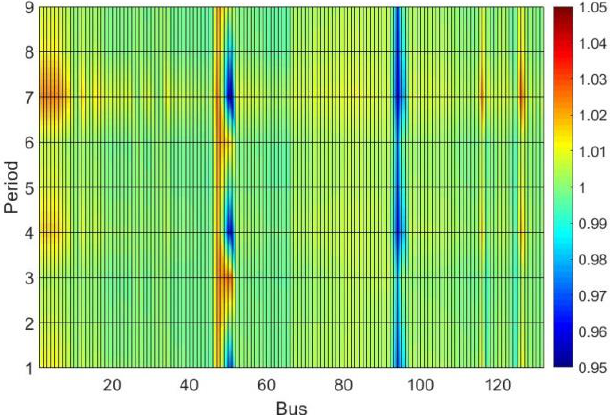
Figure 14. IEEE 123-bus system, voltage magnitudes of phase A, discrete taps, 70% PV.